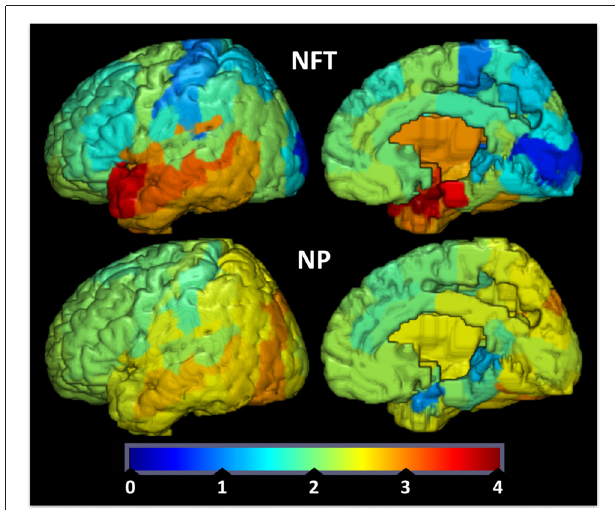
FIGURE 1 | Tau tangle (neurofibrillary tangles (NFT), upper row) and amyloid-beta plaque (neuritic plaques (NP), bottom row) values were redrawn from data originally presented in Arnold et al. (1991) and superimposed on Brodmann maps (BA 1–48) from MRIcroGL version 1.150909. NFT and NP values are double-blinded rater assessments of tangle or plaque density. Color map and bar (“jet”) is red high, blue low.